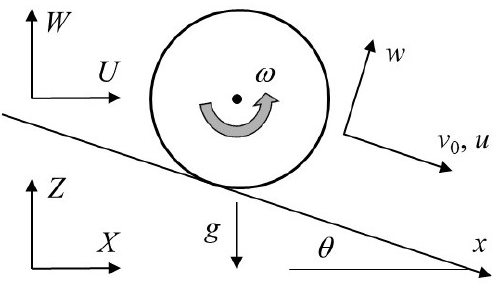
Figure D1. Definition diagram for determining travel distance λ .